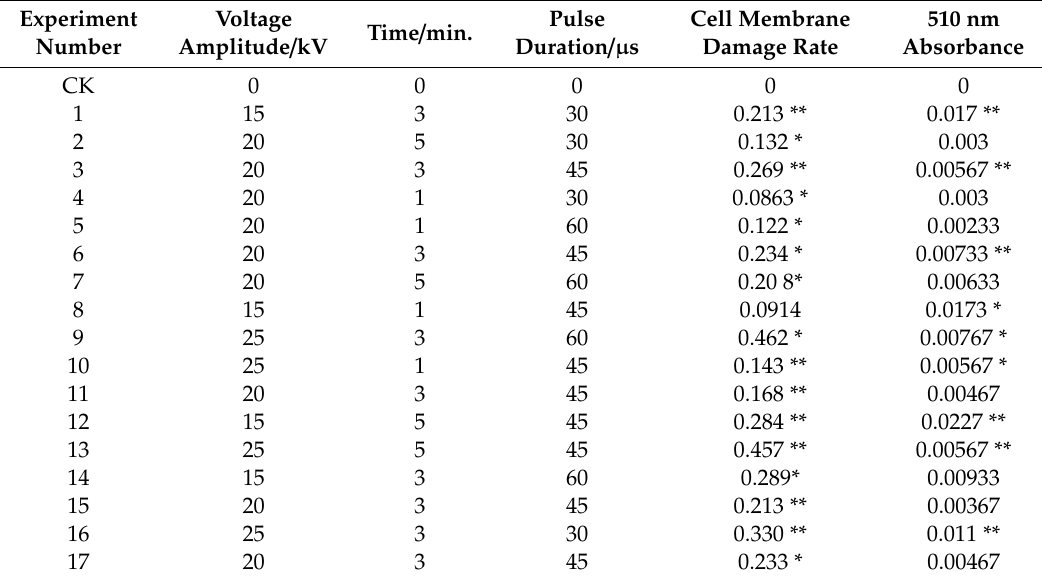
Table 3. PEF treatment orthogonal experiment